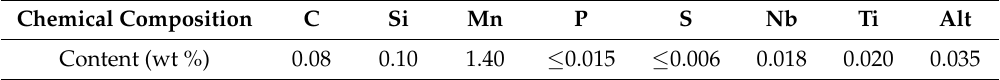
Table 1. Chemical composition and content of high strength steel B550CL.